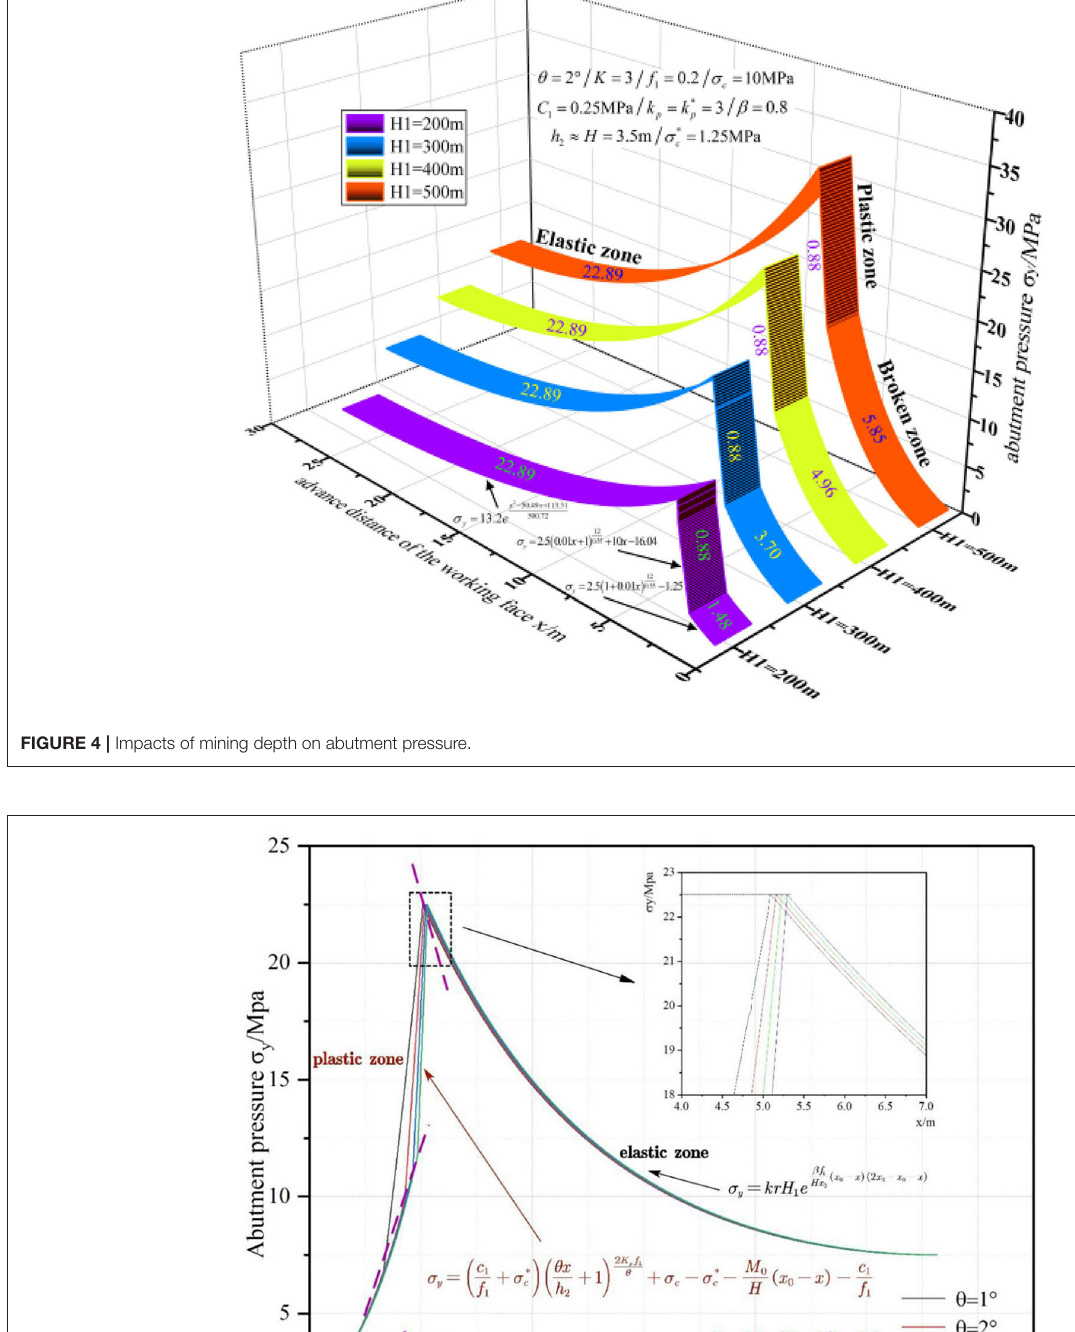
Frontiers in Physics |